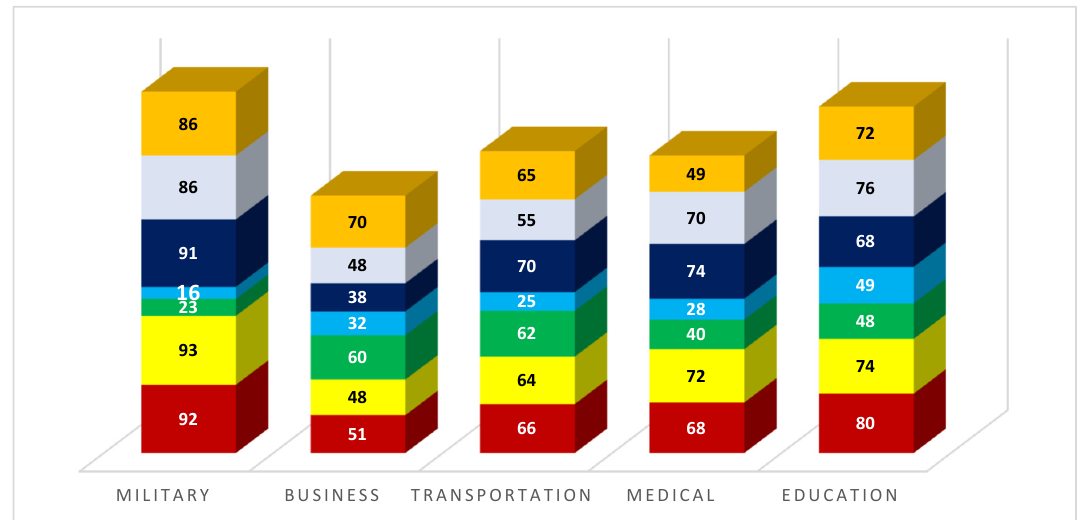
Figure 14. Results of various fields, calculated in an index, after 6G.